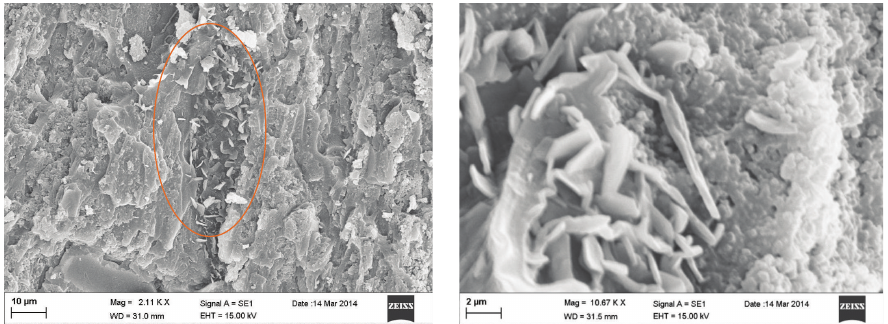
Figure 9: The SEM images of SMC composite filled with basalt